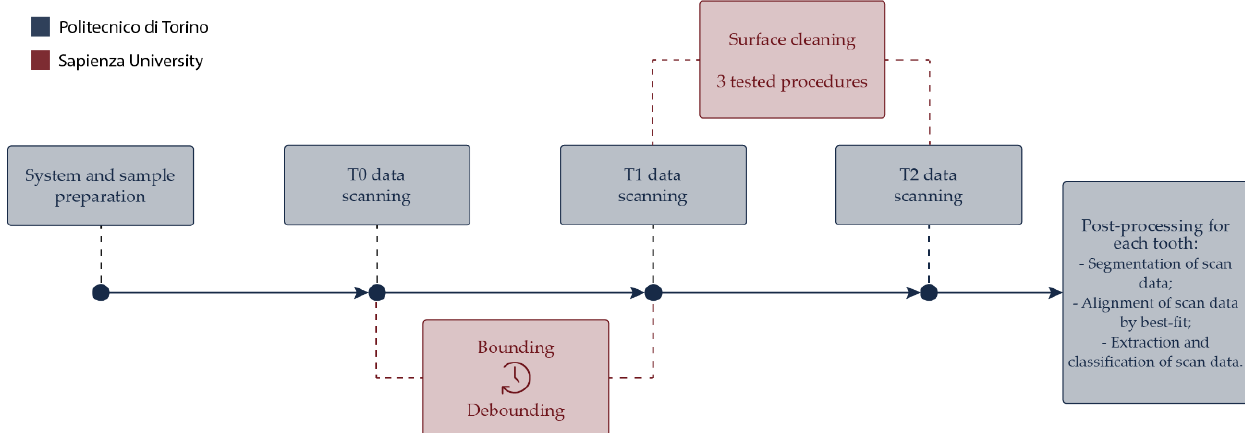
( c ) Figure 3. Cube positioning (blue frame) on tooth 21 in T0 condition ( a ), T1 condition ( b ), and T2 condition ( c ) . To trim the area of analysis, a cube with a side length of 5 mm was positioned in T1 data. The cube positioning was carried out manually by the human operator with the aid of the deviation map between the T1 surface data and the T0 reference data (Figure 4a).